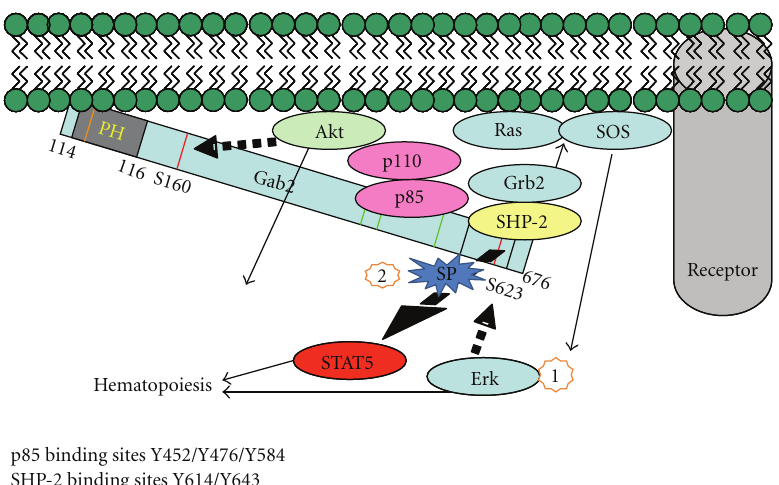
Figure 3: Potential of stapled peptides in therapeutic intervention. Step 1 illustrates how Erk phosphorylates Gab2 on a consensus phosphorylation site at serine 623, a residue located between tyrosine 614 and tyrosine 643, which are responsible for Gab2/Src homology 2 domain-containing tyrosine phosphatase- (SHP-) 2 interaction. As is reported in the text, this is part of a negative feedback loop. Hypothetically a stapled peptide (SP), a biosynthetic molecule binding to a directed region on Gab2, could be introduced in Step 2 to block the negative regulation by Erk to keep SHP-2 active and STAT5 inactive. Alternatively, it may be necessary to block SHP-2 binding to Gab2 depending on the disease entity. This figure elaborates how targeted therapy might provide new direction into understanding the interactions between adapters, like Gabs, and their partners, and which could ultimately be applied as leukemia therapy.